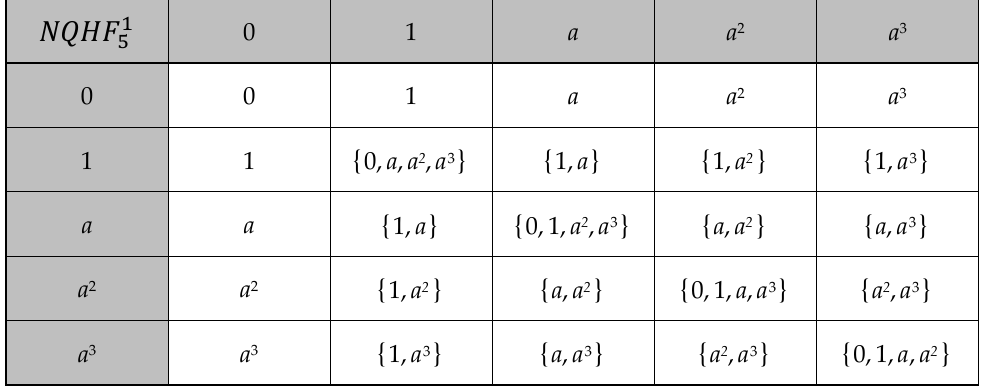
Table 23. The Cayley table of the additive canonical hypergroup of the non-quotient hyperfield constructed via Theorem 10.